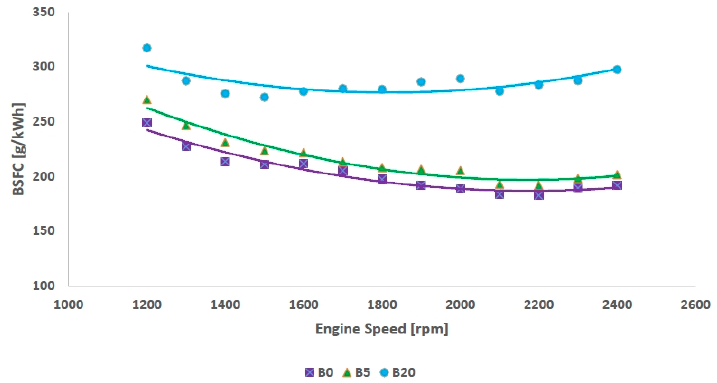
Figure 7. Variation of brake specific fuel consumption with speeds.